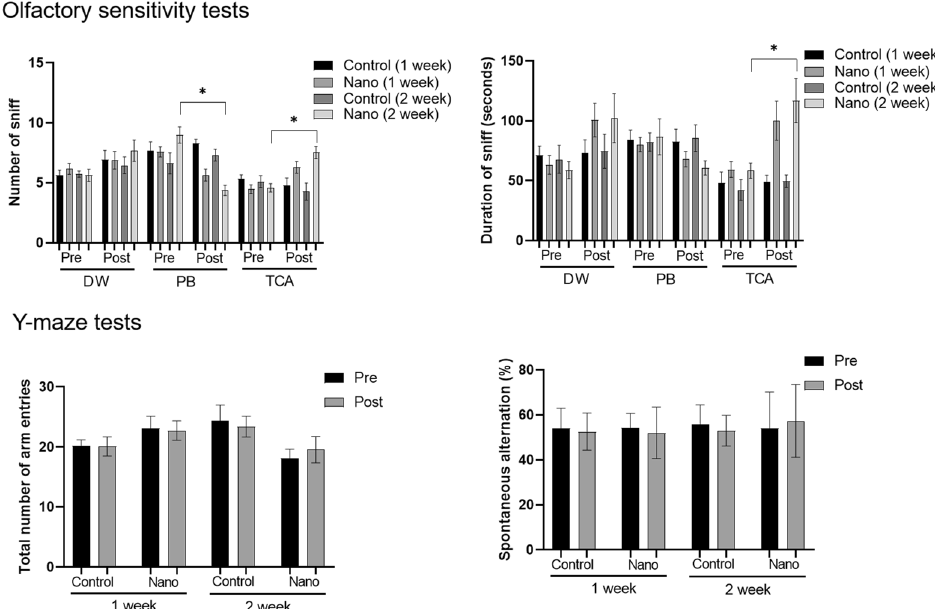
Figure 2. Changes in the frequency and duration of sniffing in the olfactory sensitivity test as well as total number of arm entries and percentage of spontaneous alternations in the Y-maze test after exposure to nanoparticulate matter. In the nano group (n = 17 per group for 1-week exposure and n = 19 per group for 2-week exposure), the number of sniffs decreased for the attractive scent [peanut butter (PB)] and increased for the aversive scent [trichloroacetic acid (TCA)] after exposure to nanoparticulate matter. *, P < 0.05, paired t-test, pre- vs.